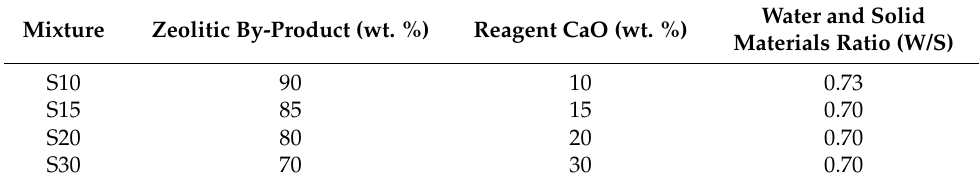
Figure 7. Photograph of the: ( a ) zeolitic by-product; ( b ) coarser fraction of sorption material based Table 5. The composition of the initial material mixtures. on straetlingite.